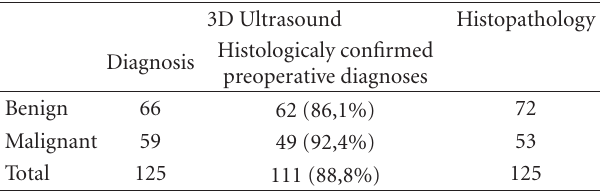
Figure 1: 3D pictures of a fibroadenoma. Table 2: 3D Ultrasound findings compared with histopathology reports.